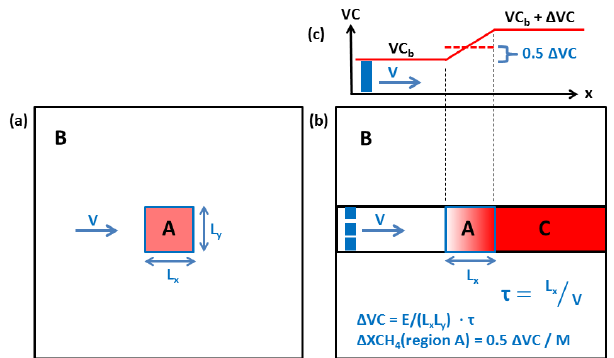
Figure 3. Sketch of a simple model used to explain the methane emission estimation method. (a) Source region A (of size L x L y and with L x in wind direction; wind speed magnitude V ) with el- evated X CH 4 (light red) and surrounding (background) region B (white area). (b) Air parcels (blue squares) moving with constant speed V over a source region with emission E/ ( L x L y ) , where E is the source area emission in CH 4 mass per time, while accumu- lating methane during accumulation time τ ( = L x /V ). (c) Before entering the source region, the air parcels are characterized by a background methane vertical column, V C b , in units of CH 4 mass per area. When leaving the source area their vertical column has been enhanced by (cid:49)V C = E/(L x L y ) × τ . When passing over the source region, their vertical column increases linearly and, there- fore, the average column enhancement over the source region is 0.5 × (cid:49)V C . V C (CH 4 mass per area) can be converted to X CH 4 (ppb) via a factor M (unit: mass per area and